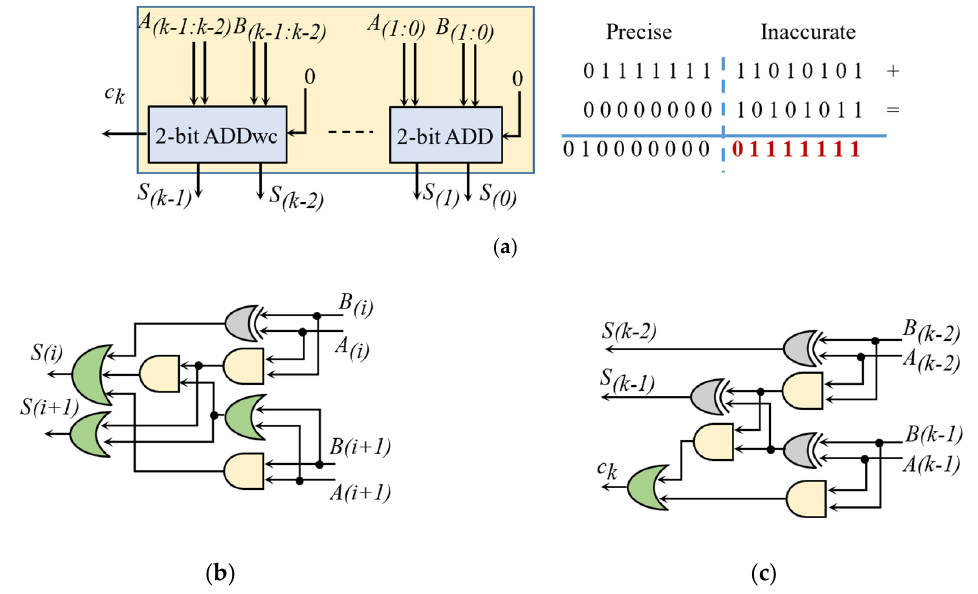
Figure 3. The proposed approximate adder: ( a ) the top-level structure; ( b ) the ADD module; ( c ) the ADDwc module.